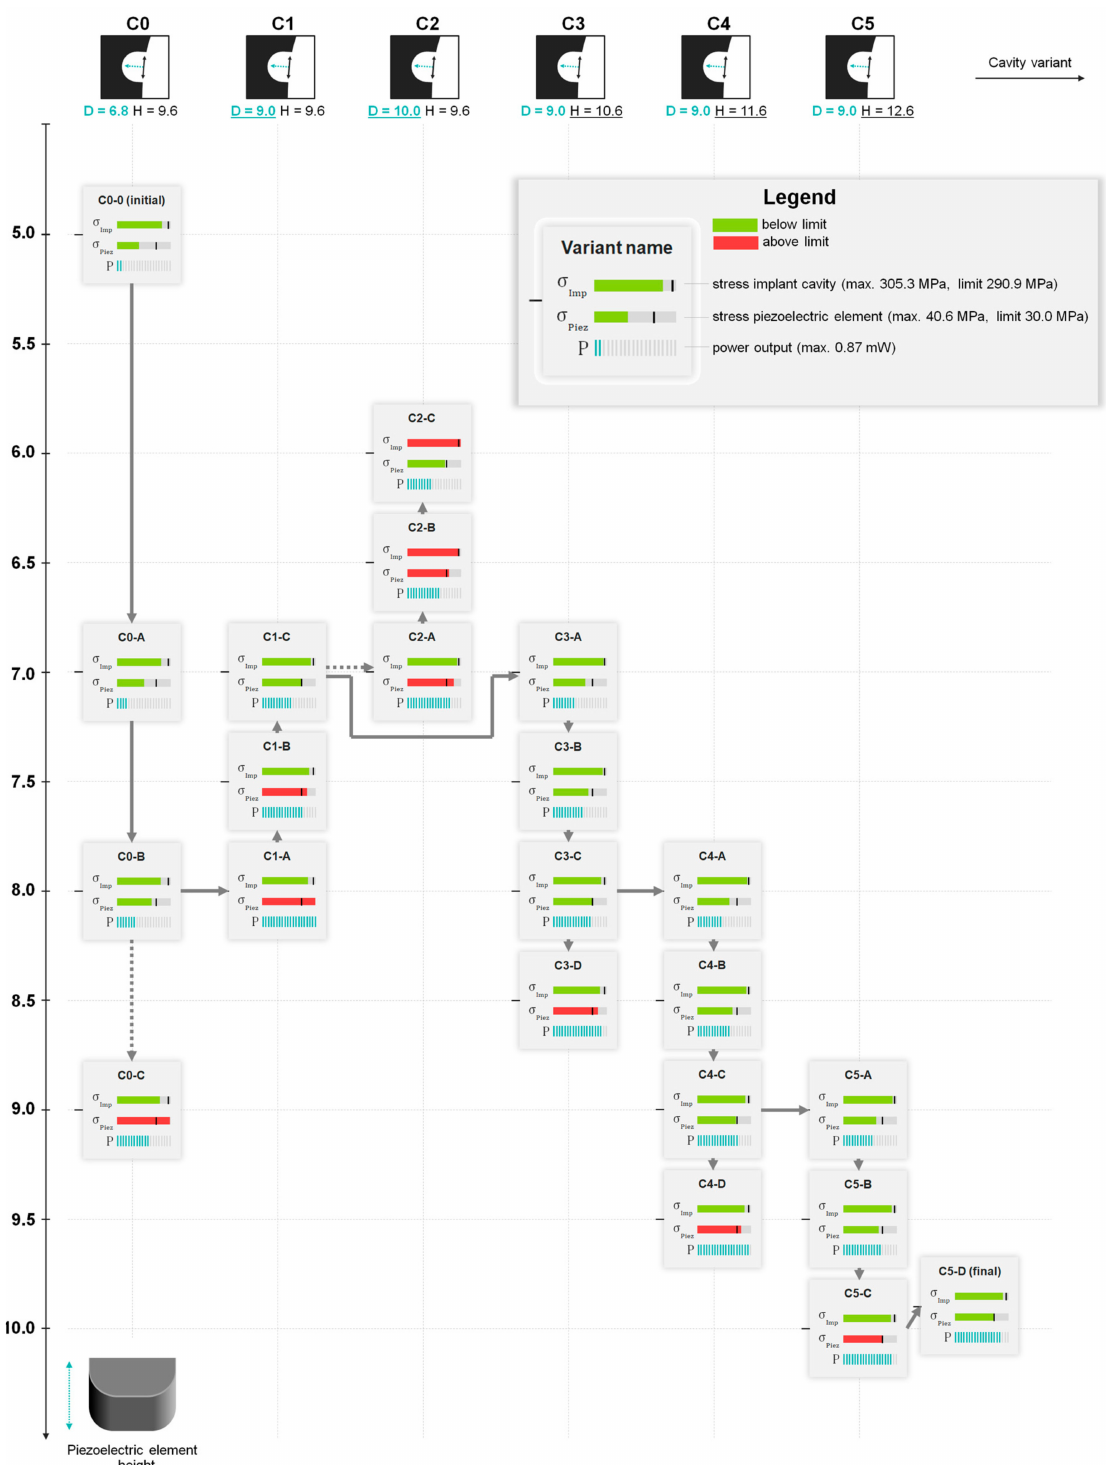
Figure A1. Variants of the geometry study for the customised geometries showing the different cavity designs from left to right (the changed cavity parameters are underlined), all design points are ordered according to the height of the piezoelectric elements (top down). The arrows indicate the proceeded progress. The evaluated stresses (MPa) and power (mW) are shown in bars based on the maximum reached values. Green bars indicate a value below the critical value, and red above. For quantitative date, see Table